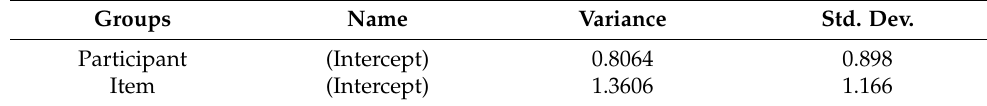
Table A17. Syrian Arabic T2 random effects.